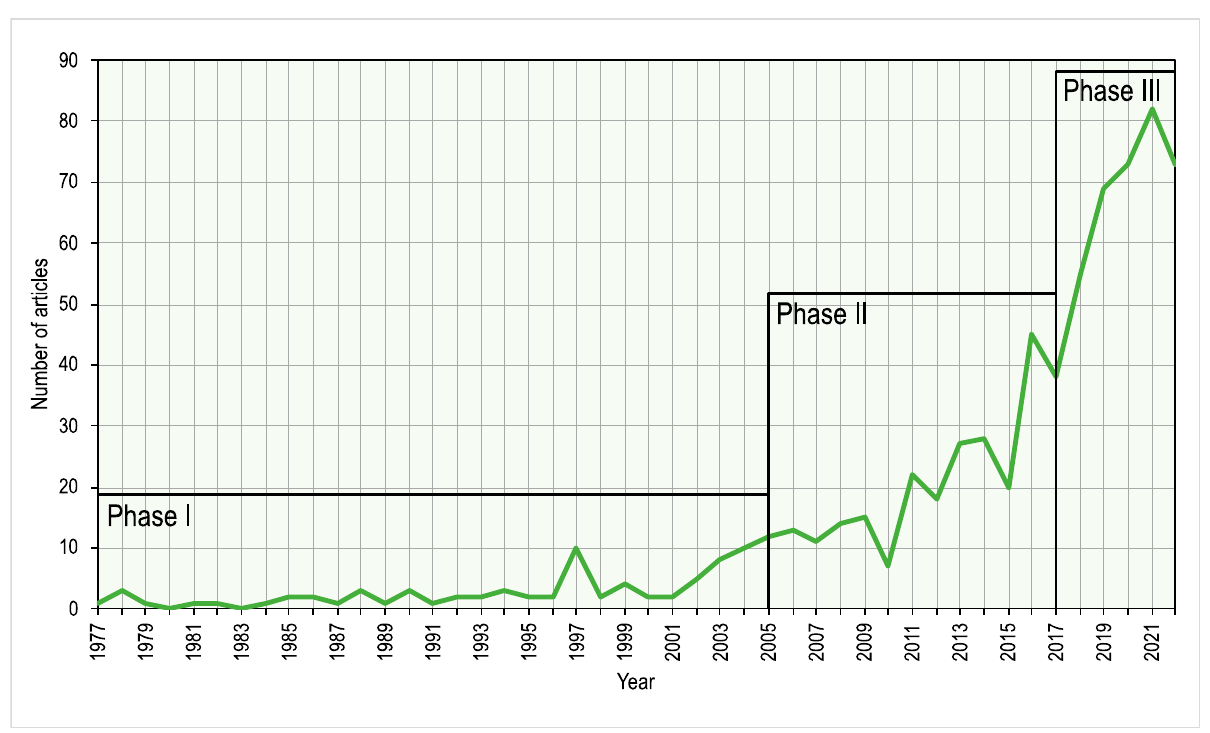
Figure 17. The time interval of the optical SDB method application divided into three phases according to the annual number of published articles.